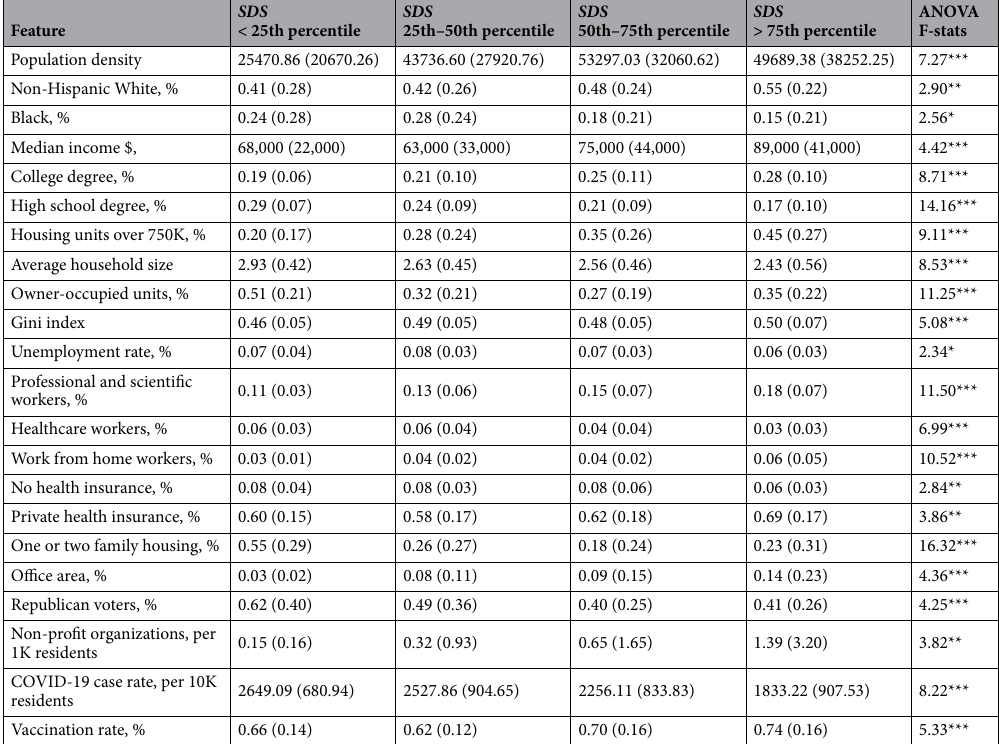
Table 2. Descriptive statistics of neighborhood groups by social distancing sensitivity ( SDS ) quartile. 22 features with statistically significant differences between groups based on one-way ANOVA and Tukey’s